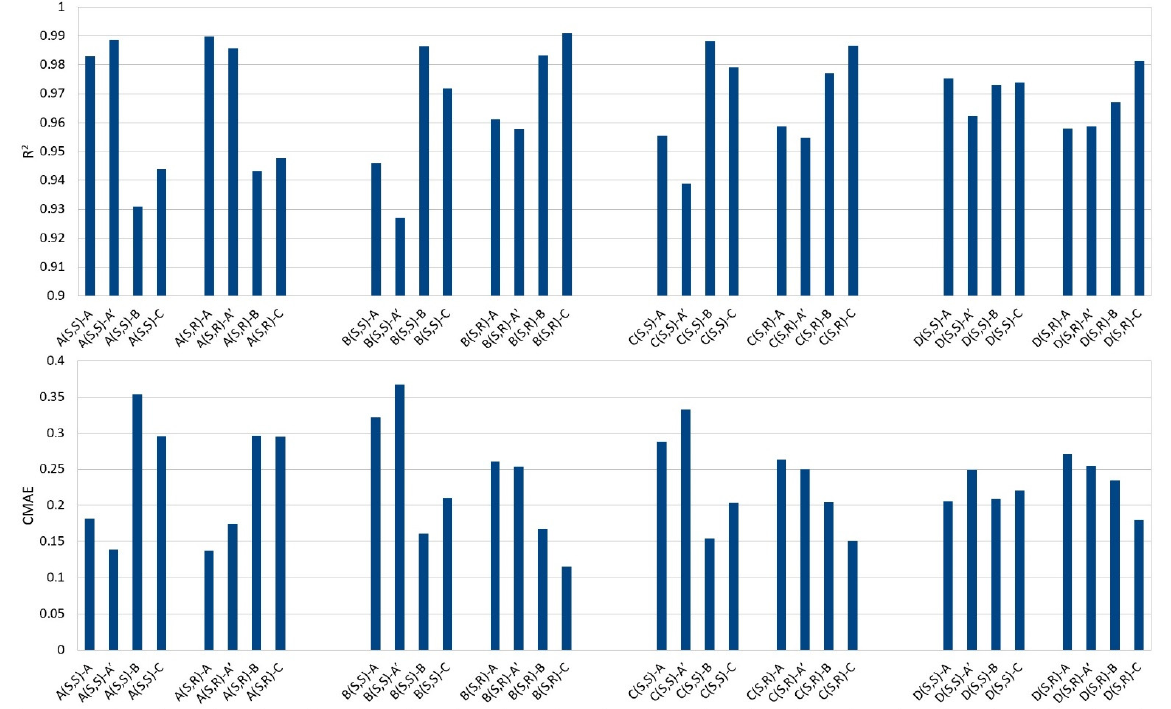
Figure 2. ( Top ) Correlation coefficients, R 2 , obtained from the linear fitting of calculated vs. experimental 1 H chemical shifts. For each molecule tested, A , B , C, and D , we have two diastereoisomers, (S,S) and (S,R), where the first label refers to the chain carbon and the second to of 1 H resonances, labeled A , A’ , B, and C in Table 1. ( Bottom ): Corrected Mean Absolute Errors (CMAE) for the same correlations.